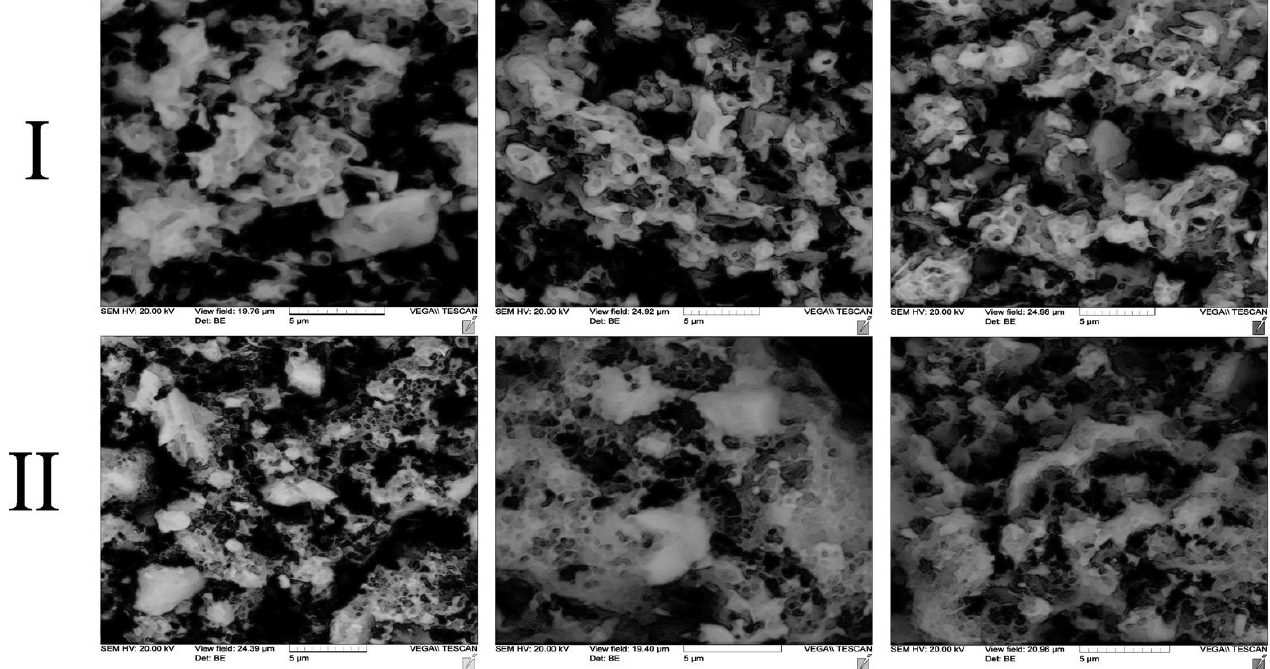
Figure 6. Microstructure of carbonated mortars of Chufutkale buildings (Crimea): I —old wall (sample E-20-KR-CHU-1), II —tomb (sample E-20-KR-CHU-4).